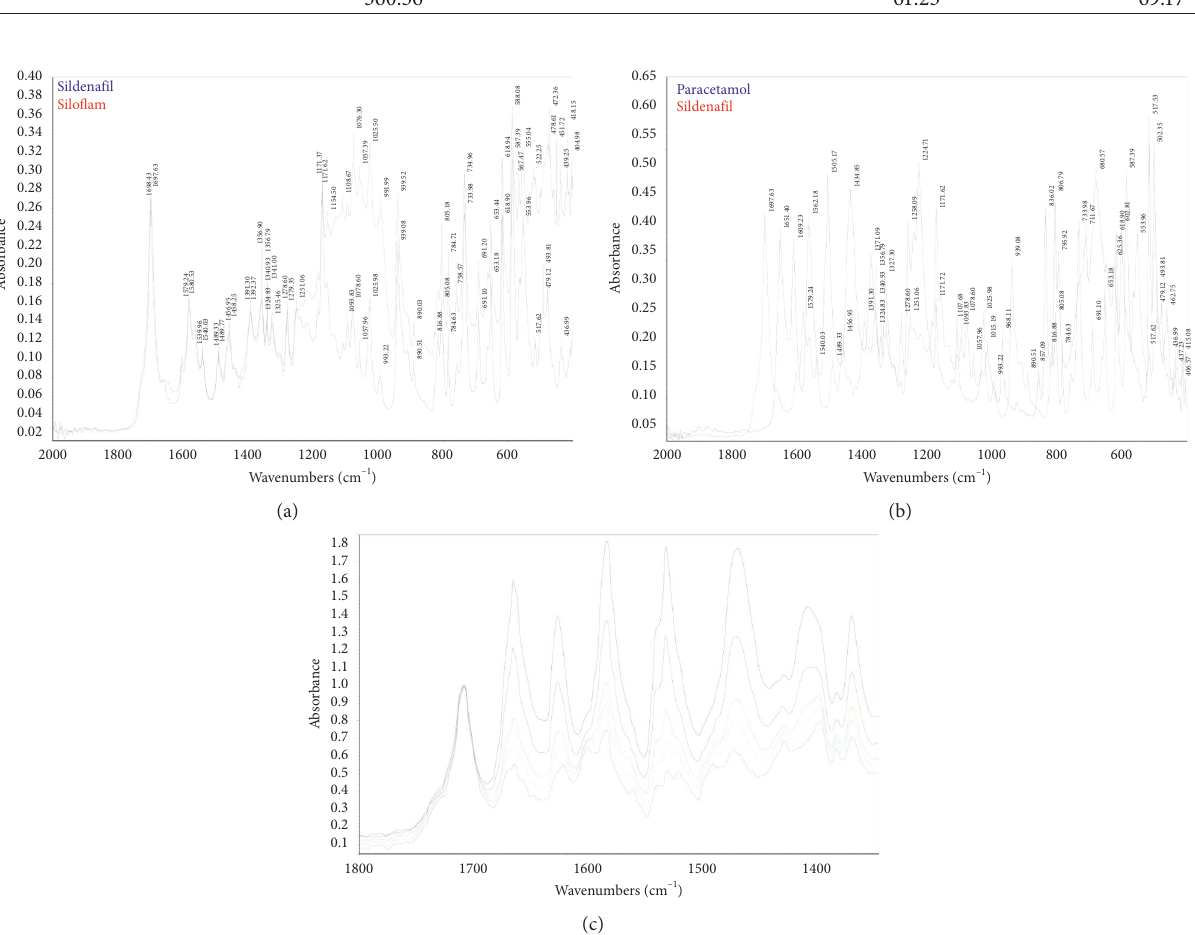
Figure 1: Comparing IR spectra of sildenafil citrate and Siloflam tablet powder (a). IR spectra of sildenafil citrate and paracetamol (b). IR spectra of some working standard mixtures with different R values